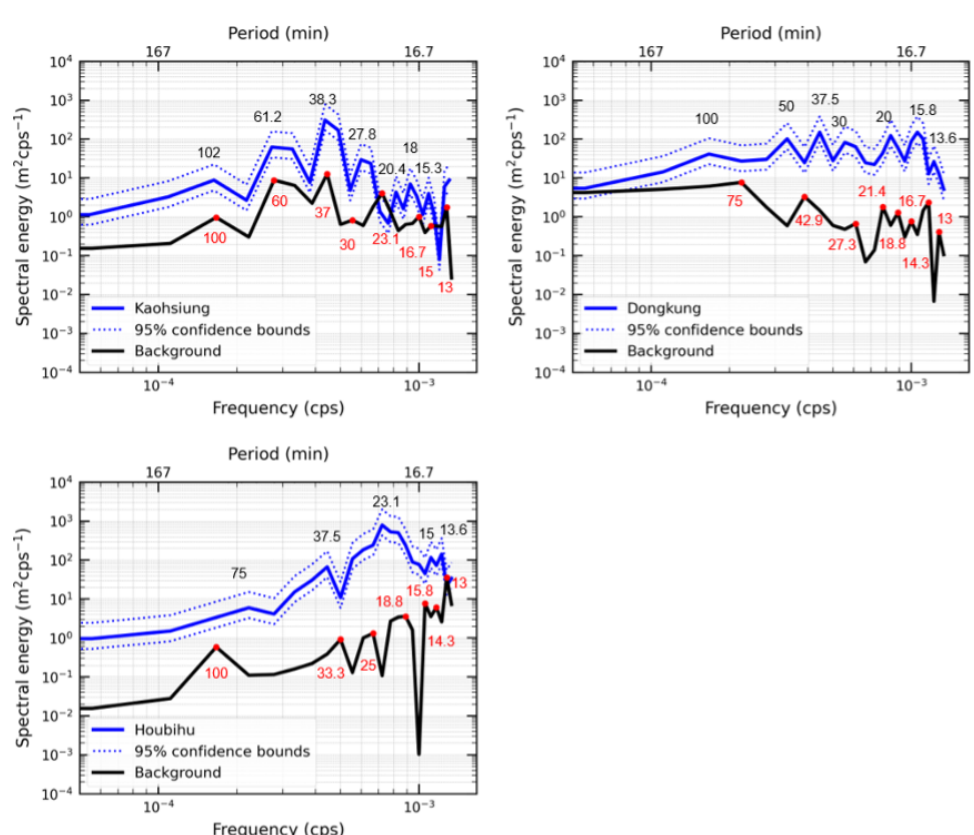
Figure 10. Respective spectra of the observed tsunami waveform (solid blue lines) at each tide gauge station. The solid black lines are spectra for the background signals before tsunami arrivals at each station. The red circles denote the dominant periods of the background spectra.